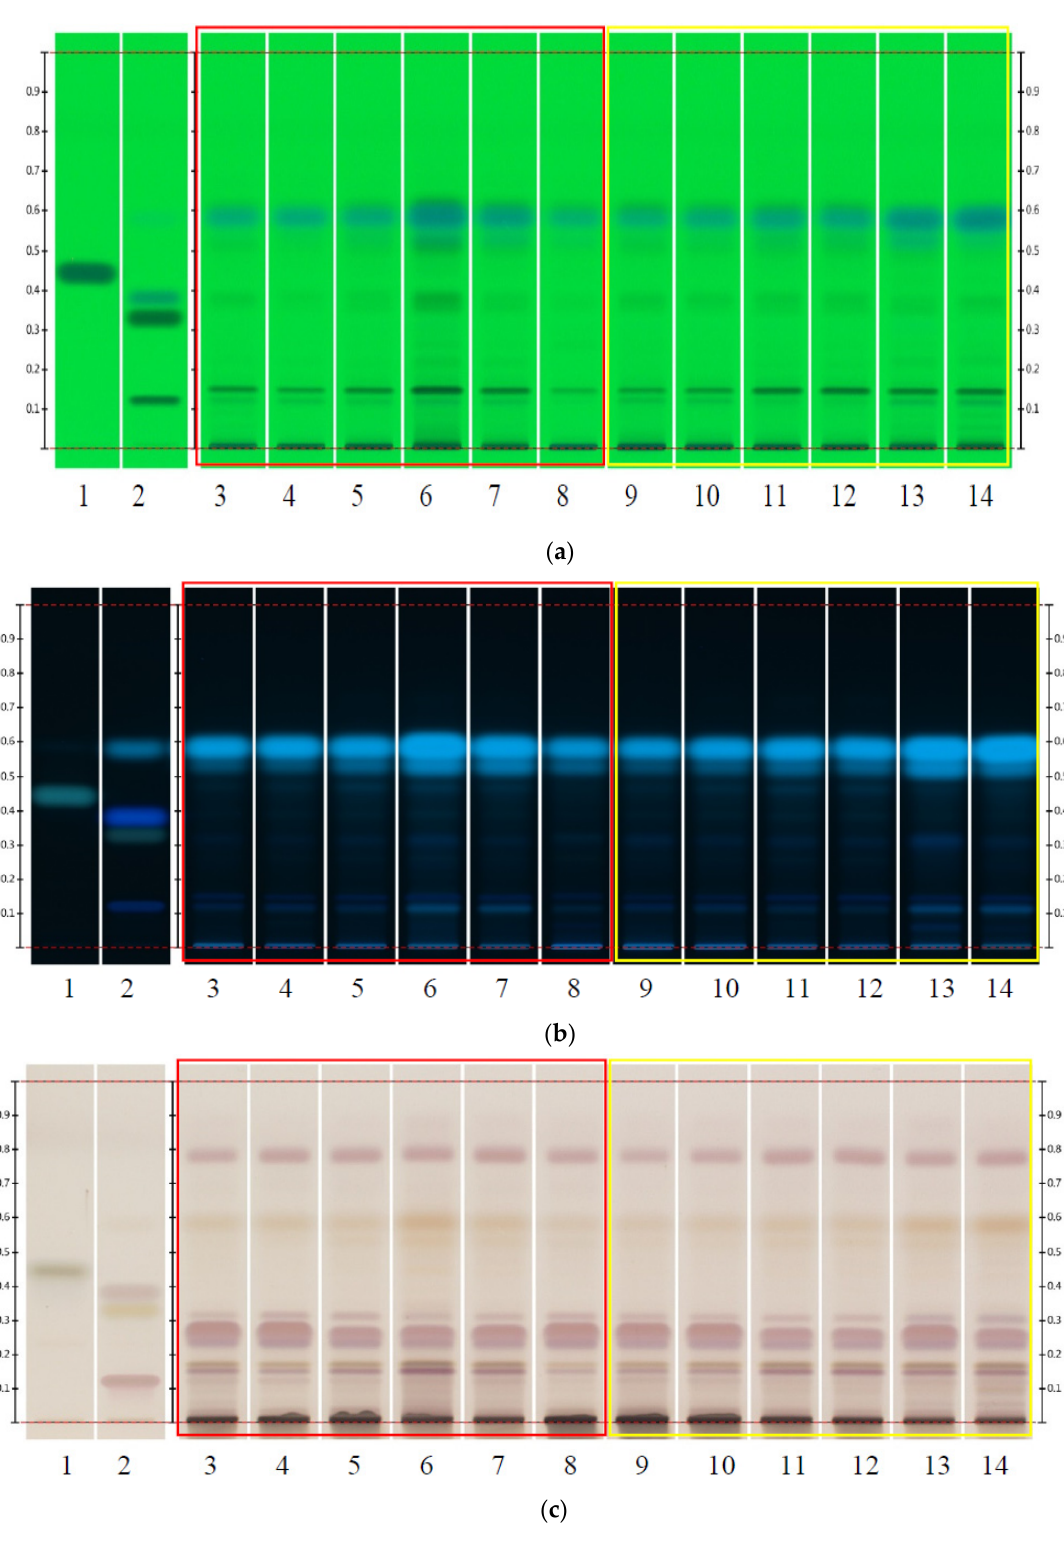
( d ) Figure 2. HPTLC fingerprints of Angelica sinensis cultivated in Gansu (tracks 3–8) and Yunnan (tracks 9–14). Isoimperatorin (R f = 0.46), Imperatorin (R f = 0.38), ferulic acid (R f = 0.12), osthole (R f = 0.33) and Z ‐ ligustilide (R f = 0.59) were used as reference substances. ( a ) Image of the plate prior to derivatization under UV 254 nm; ( b ) Image of the plate prior derivatization under UV 366 nm; ( c ) Image of the plate after derivatization under WRT; ( d ) Image of the plate after derivatization under UV 366 nm. 4. Results 4.1. Cultivation of Angelica Sinensis In Gansu, the cultivation of Angelica sinensis or other medicinal plants is often the main income source, whereas in northwestern Yunnan, it comes from working small jobs and in eastern Yunnan, from cultivation of Nicotiana tabacum . Cultivation can be carried out by just one family without special equipment (small ‐ scale household cultivation), particularly in Yunnan, where average field size was 837 m 2 (SD = 242 m 2 , n = 6) in northwestern Yunnan, and 1039 m 2 (SD: 1118 m 2 , n = 5) in eastern Yunnan. In Gansu, fields were significantly larger ( p = 0.004) with an average of 3996 m 2 (SD = 2175 m 2 , n = 5) and average contribution of dang gui to total income of farmers was higher compared to Yunnan ( p = 0.054; Gansu: 62.5%, SD = 22.2%, n = 4; Yunnan: 29.2%, SD = 18.7%, n = 5). In Gansu and northwestern Yunnan, the cultivation of dang gui was described by most farmers as a family tradition or a tradition of the whole village. In contrast, in eastern Yunnan, most of the farmers started cultivation less than 15 years ago. In Gansu, cultivation starts in February or March by planting seedlings from the preceding year. Harvest usually takes place in October. In western Yunnan, the planting and harvest season lasts